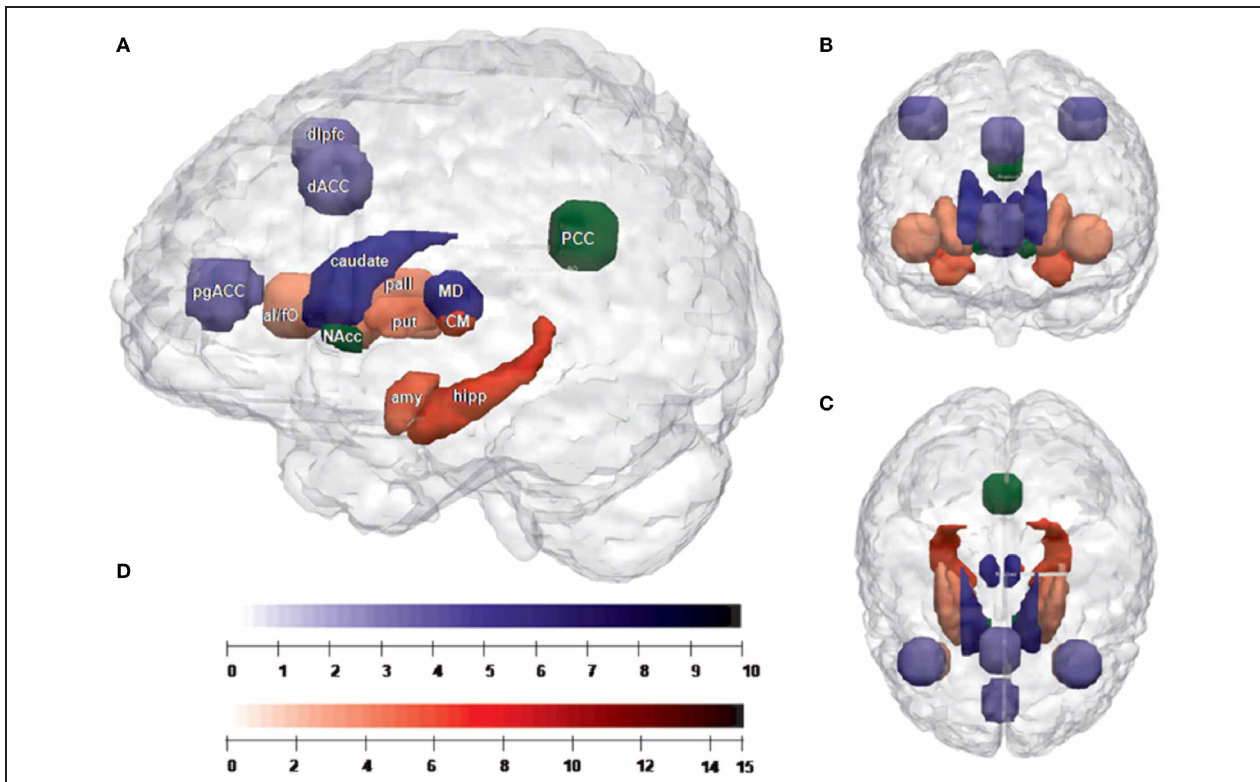
significant preferences and appear in green. Abbreviation MD, mediodorsal thalamic nucleus; CM, centromedian/parafasicualar complex of the thalamus; amy, left amygdala; hipp, left hippocampus; PCC, posterior cingulate cortex; put, right putamen; pall, right pallidum; NAcc, right nucleus accumbens; caudate, right caudate nucleus; dlPFC, right dorsolateral prefrontal cortex; dACC, dorsal anterior cingulate cortex; pgACC, pregenual anterior cingulate cortex; aI/fo, left anterior insula-frontal